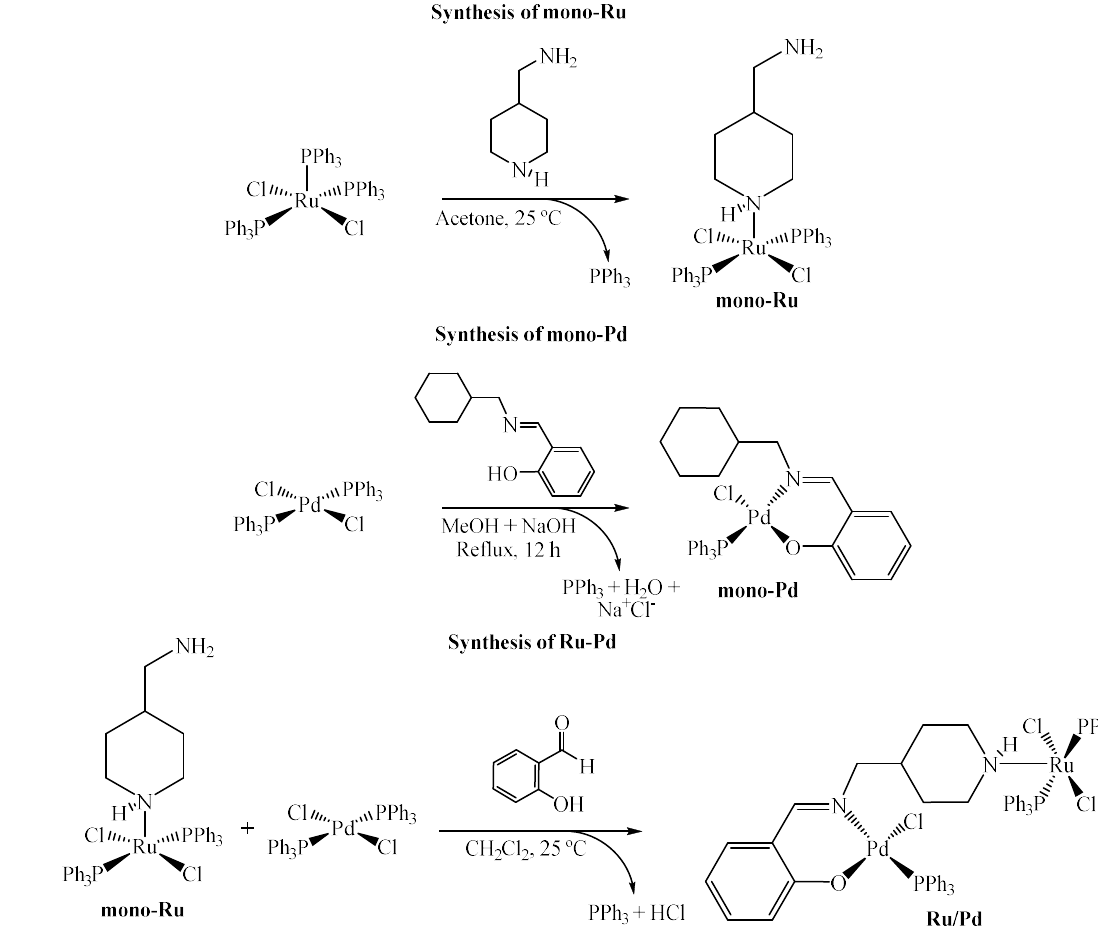
Scheme 2. Overview of reactions to obtain mono-Ru, mono-Pd, and